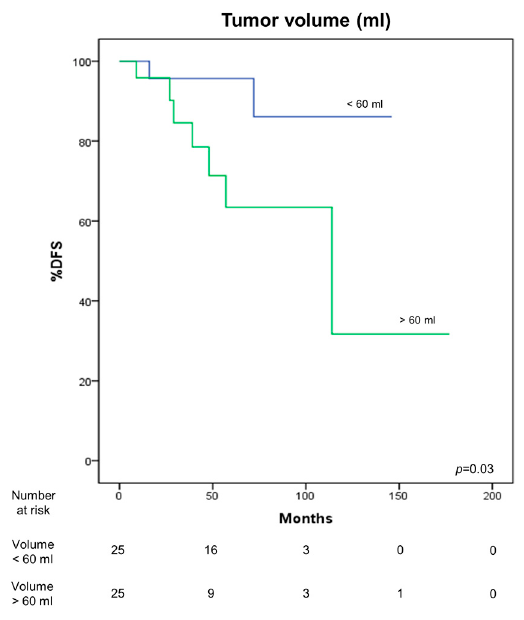
Figure 6. Correlation between DFS and tumor volume.